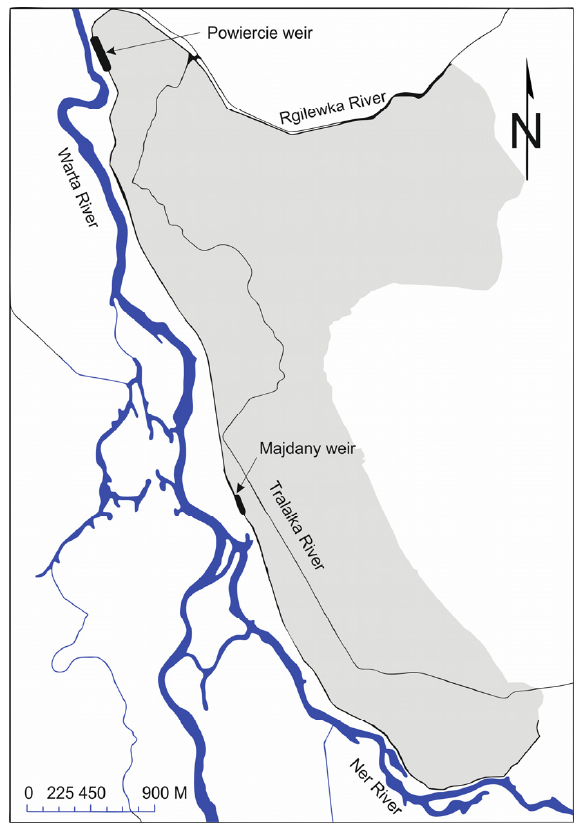
Figure 1. Study site location.